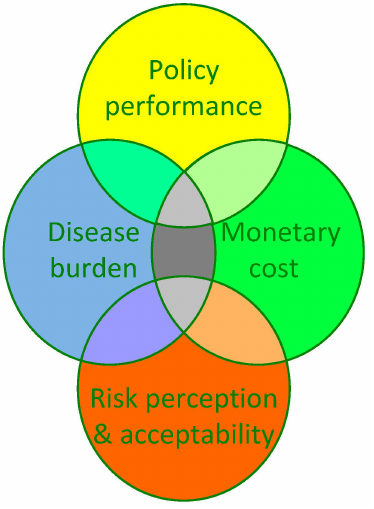
Figure 6. Differences and commonalities in (aggregate) impact indicators from different perspectives relevant to Integrated Environmental Health Impact